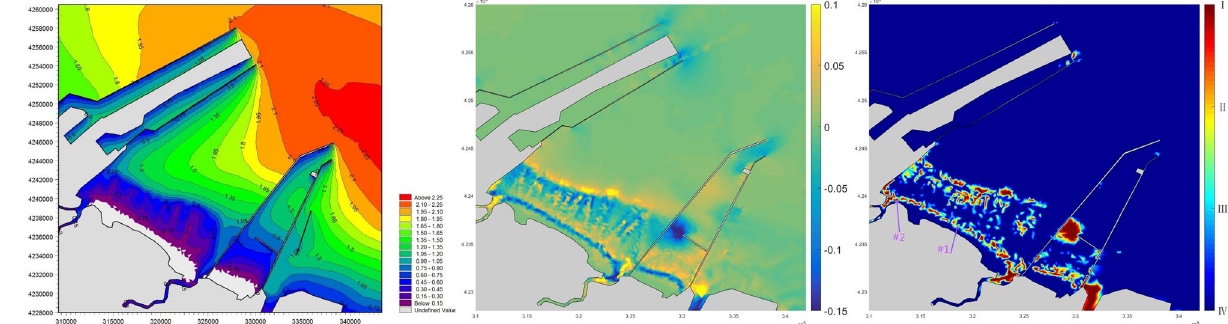
Figure 7. Typhoon Rumbia: simulated significant wave height; Computed net seabed changes by erosion and deposition; Damage state (I: highest, IV: lowest) assessment of clams with averaged shell length of 3.5 cm (processed by Mike 21 at https ://www.mikep owere dbydh i.com/produ cts/mike-21). Location # Quantity (before) Quantity (after) Loss rate